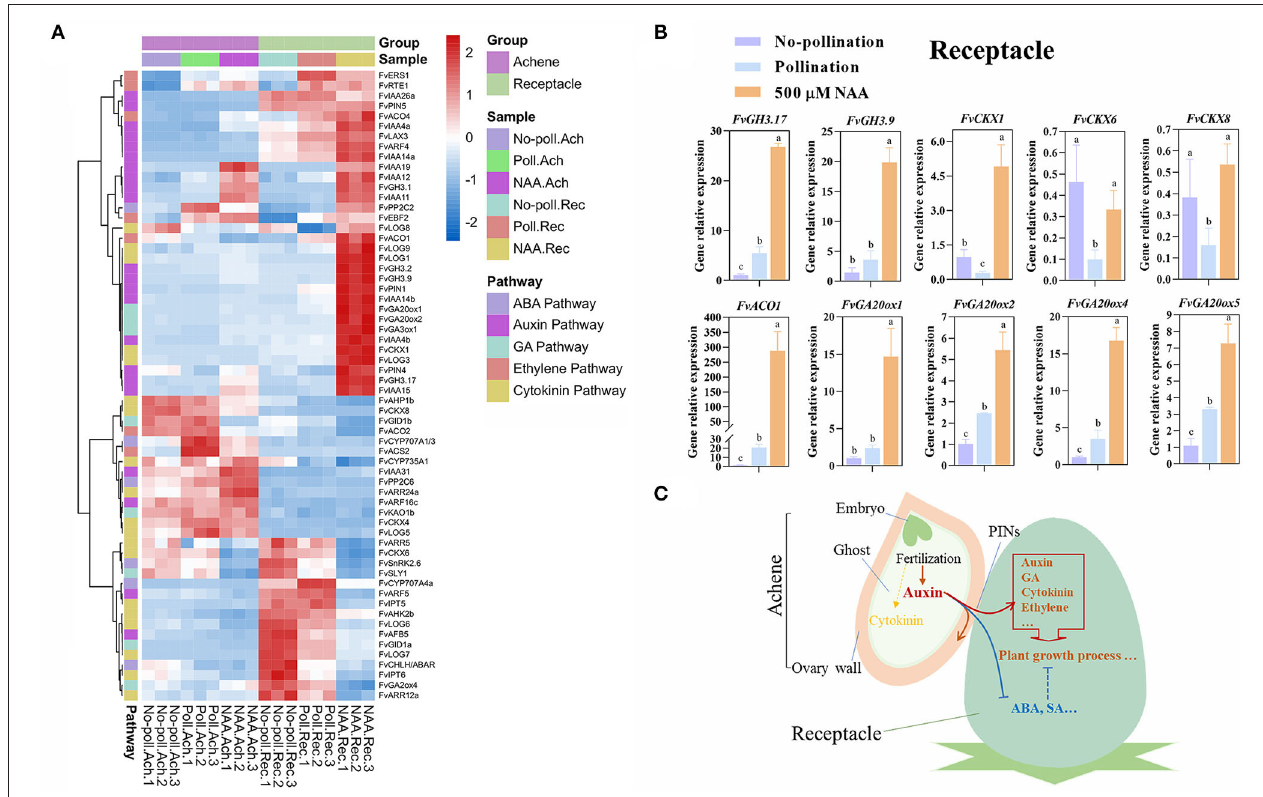
FIGURE 7 | Characterization of auxin action during fruit set. (A) Expression patterns of hormone pathway genes. DEGs were classified through gene functional annotation and genes specially regulated by auxin in achenes or receptacles. For heatmap analysis, the expression values were transformed to log2(value + 10 − 6 ). P < 0.05, |log2(fold change)| > 1.5. Hormone pathways are noted in the left line, and samples for five treatments and the samples belonging to achenes or receptacles were annotated. (B) Expression of several genes were verified in receptacles through qRT-PCR. Receptacles were treated with No-pollination, pollination, and 500 µ M NAA for 1 day. Error bars represent SD of three independent replicates. Different characters represent the significant differences ( p < 0.05, one-way ANOVA). (C) Predictive regulatory mechanisms for auxin in promoting fruit